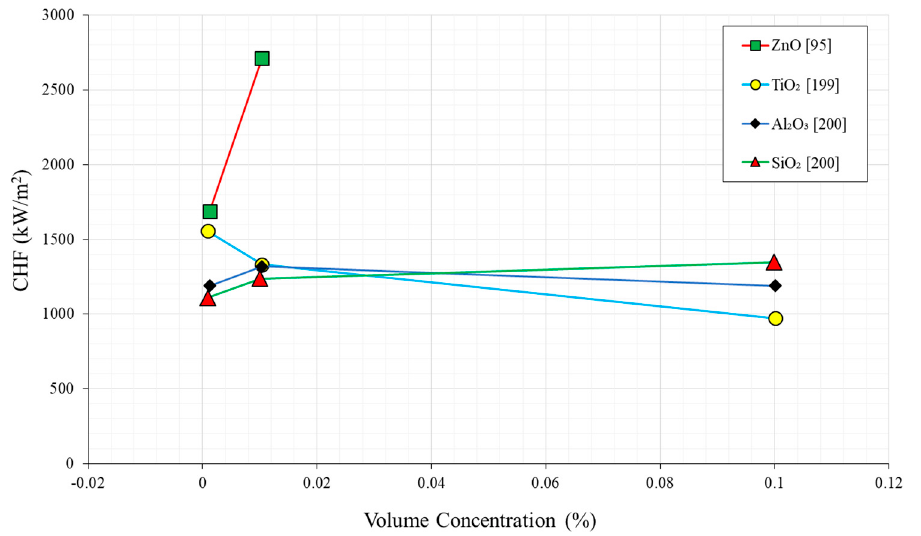
Figure 11. Variations of CHF against volume concentration for diverse nanofluids. Adapted from Prakash and Prasanth. Reproduced from [201], Elsevier: 2018.